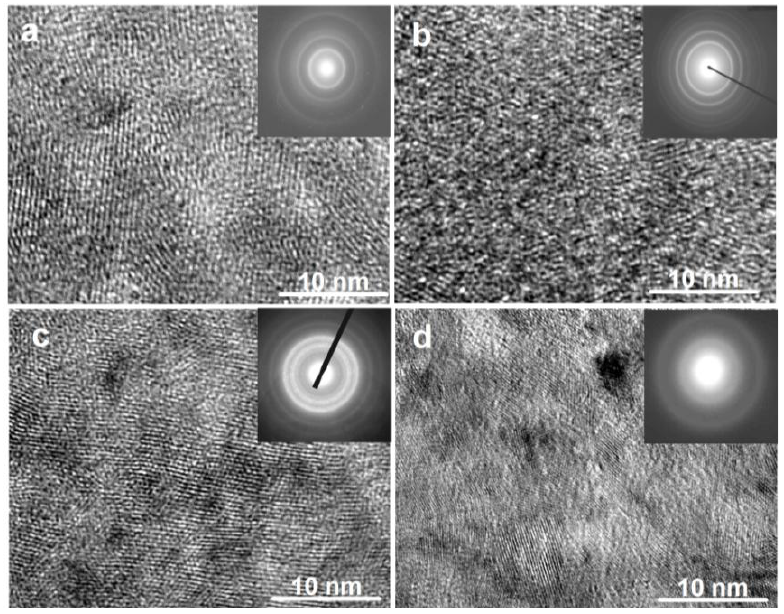
Figure 2. High resolution transmission electron microscope (HRTEM) micrographs and electron diffraction (ED) patterns of the as-spun alloys: ( a ) as-spun (15 m/s) Co ( b ) as-spun (30 m/s) Co alloy; ( c ) as-spun (15 m/s) Co 0.1 Co 0.4